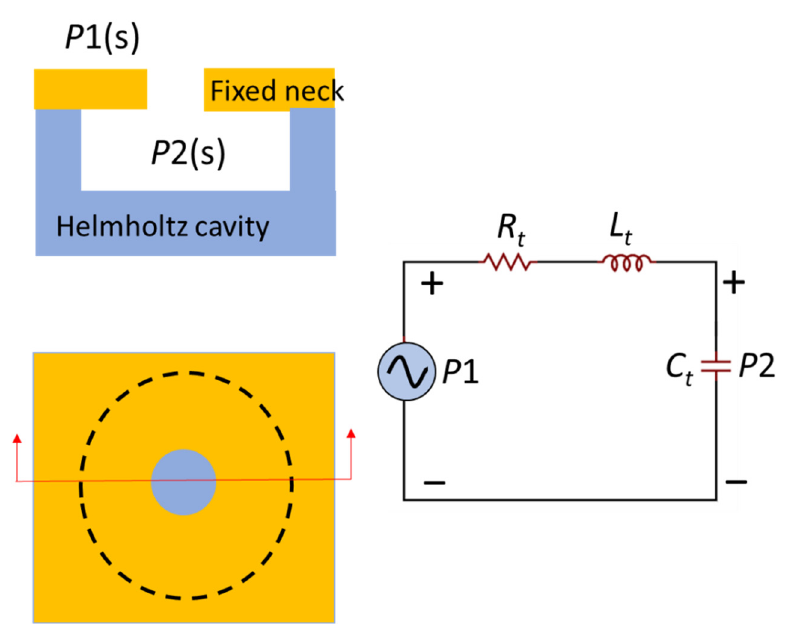
Figure 12. The equivalent circuit of the conventional Helmholtz resonator model.